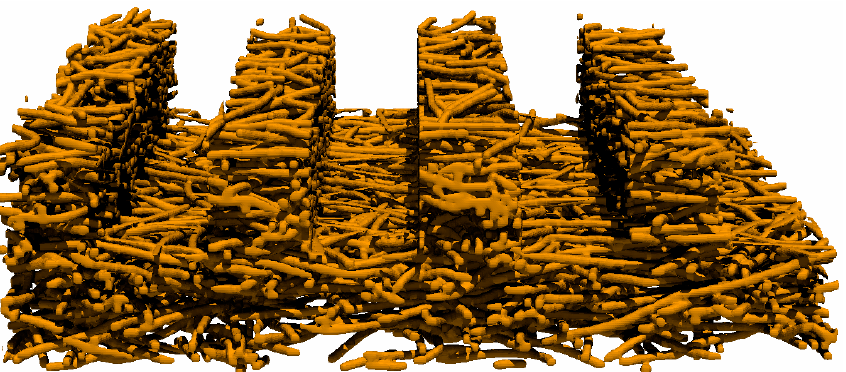
Figure 1. Illustration of a combination of straight line microchannels above the fibrous porous struc ‐ ture.